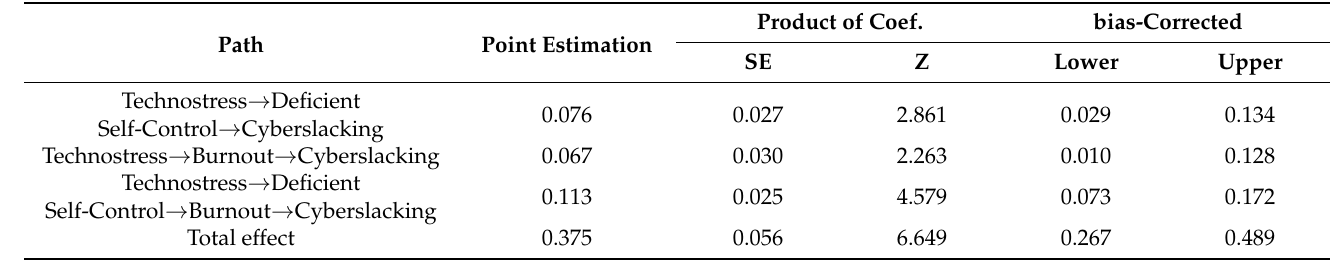
Table 5. Results of the bootstrap